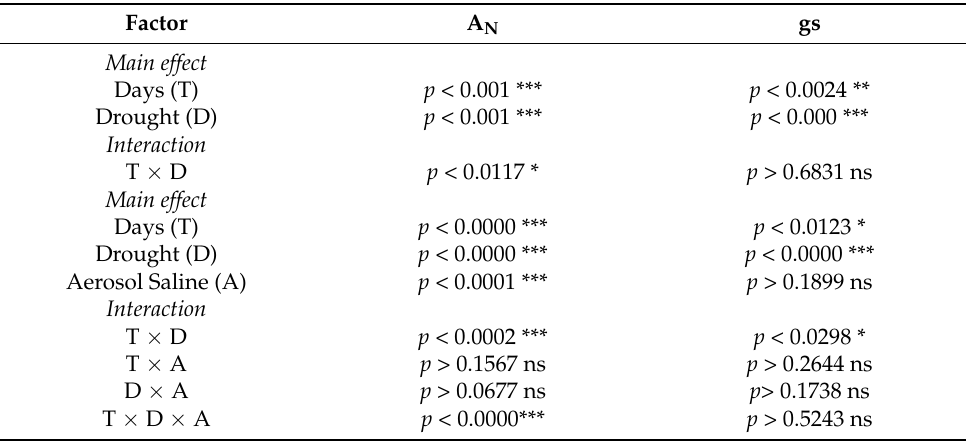
Data were subjected to two-way ANOVA to compare the effects of days (T) and drought (D), while data were subjected to three-way ANOVA to compare the effects of days (T), drought (D), saline aerosol (A). Significance of differences of parameters: ns = not significant; * p < 0.05; ** p < 0.01; *** p <